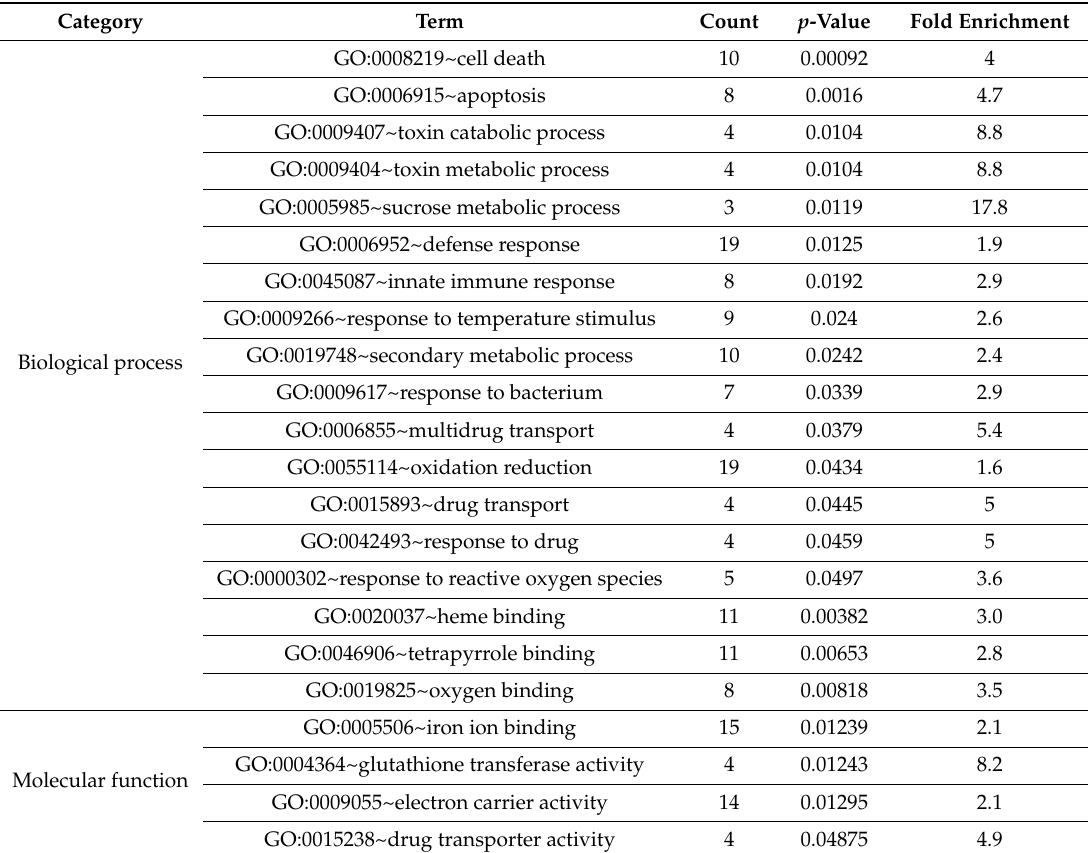
Table 1. Gene ontology terms ( p -value and fold enrichment) that were significant in the enrichment analysis in the gene list from the red vs. green mizuna cultivar